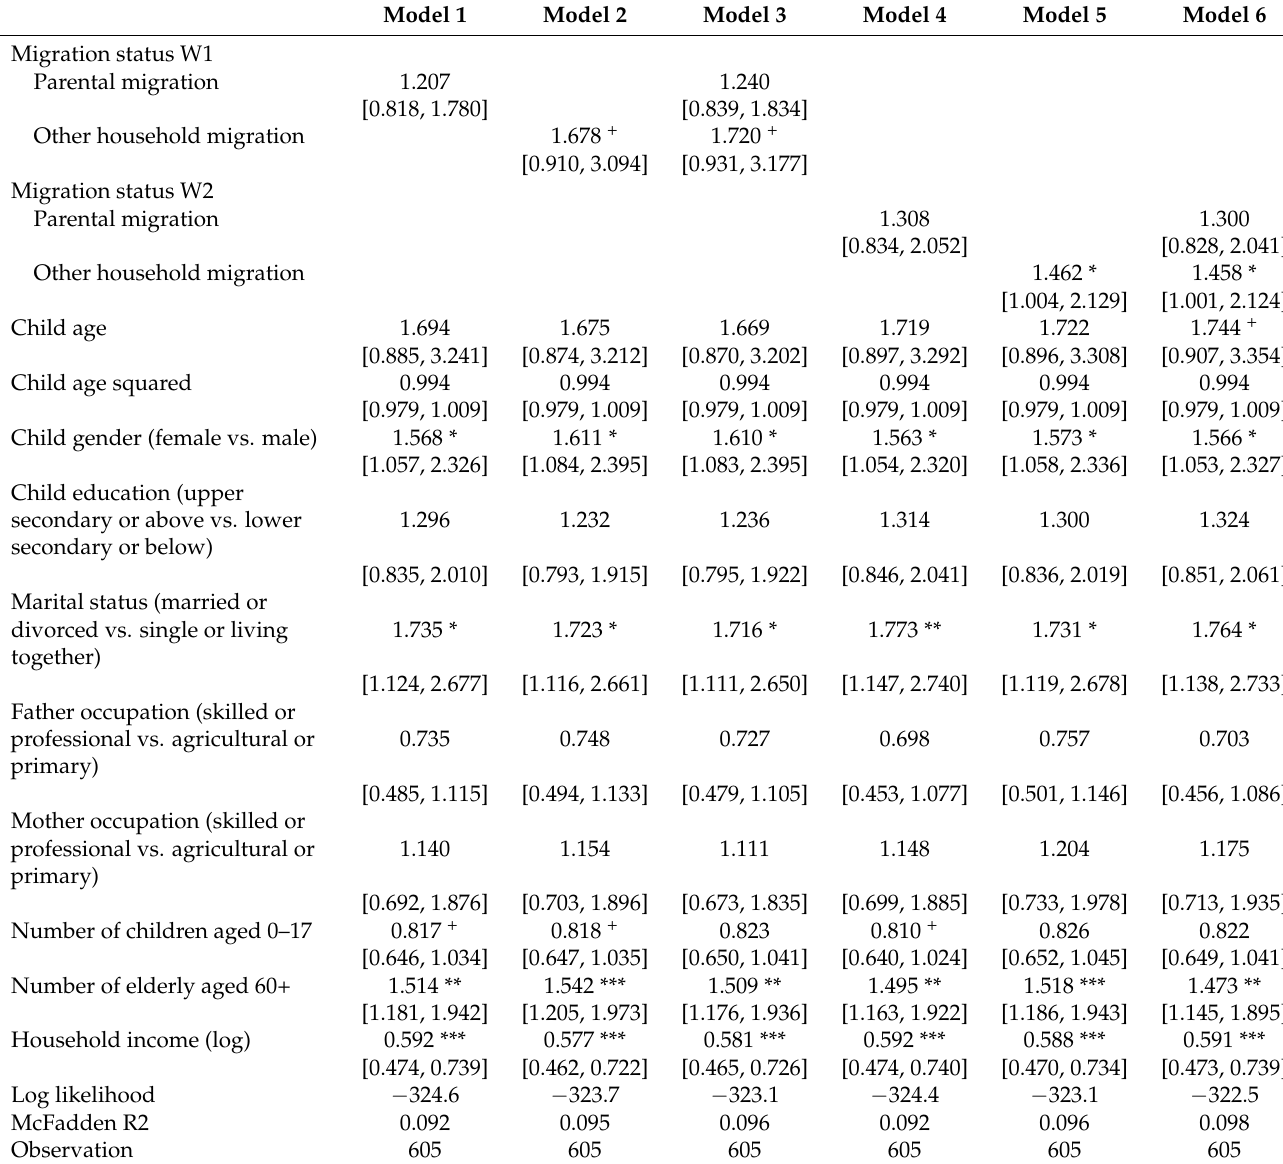
Table 3. Effects of network migration on youth labor